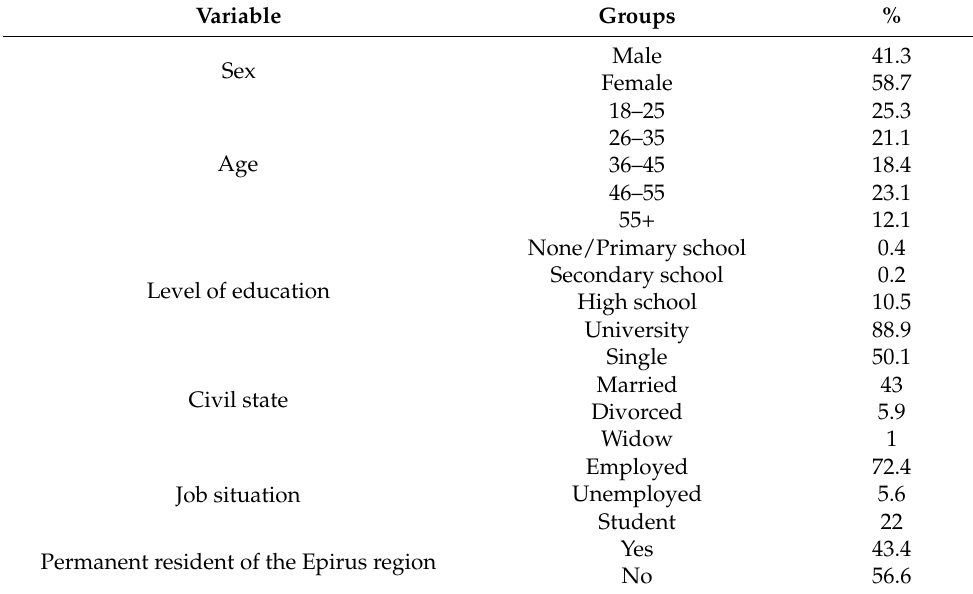
Table 1. Sociodemographic characterization of the